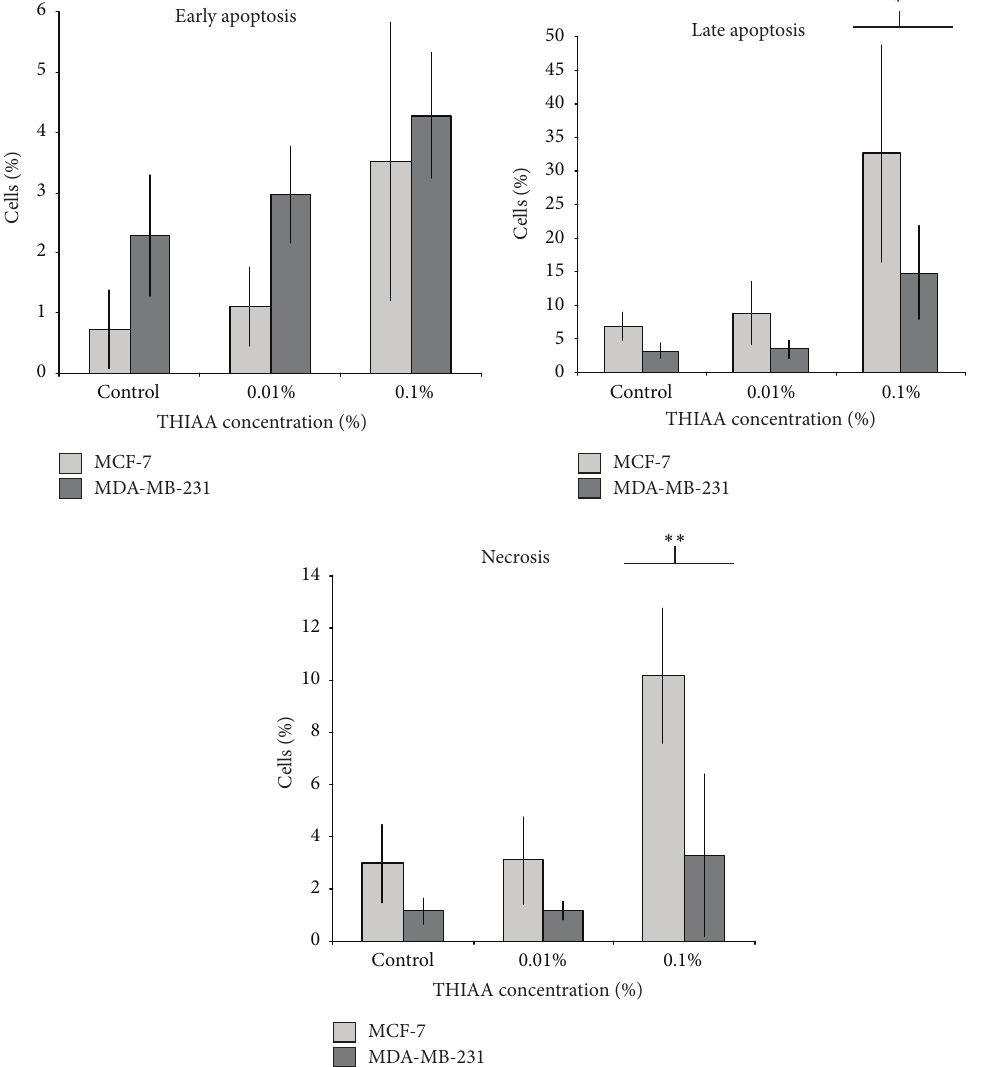
Figure 3: THIAA induced apoptosis in serum-complete condition. MCF-7 and MDA-MB-231 cells were treated (or not: control) during 24 h with indicated concentrations of THIAA. Early and late apoptosis as well as necrosis were assessed by flow cytometry after annexin V-FITC/propidium iodine labeling. Data refer to the mean value ± SD of three independent experiments; ∗ 𝑝 < 0.2 ; ∗∗ 𝑝 < 0.05